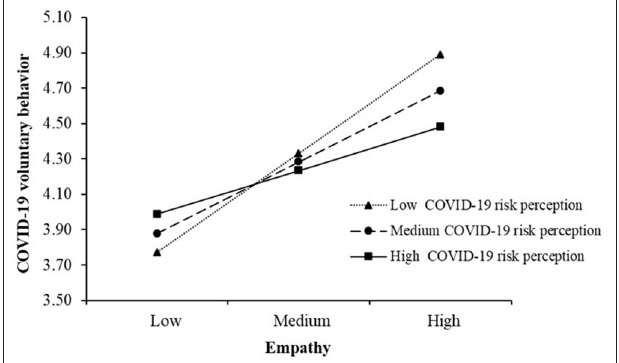
FIGURE 1 | Simple slopes of empathy on COVID-19 volunteer behavior under different levels of COVID-19 risk perception.